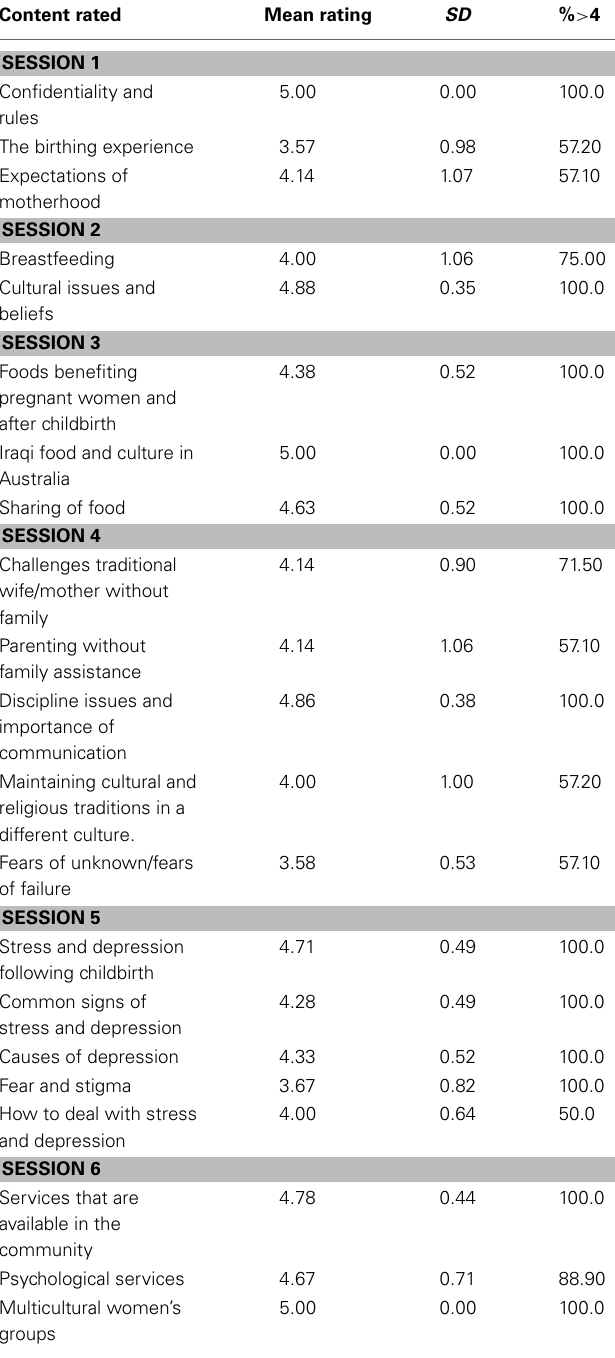
Table 4 | Mean participant ratings of the enjoyment of the individual Sessions (1, not at all enjoyable; 5, I enjoyed it very much), with the percentage of participants who gave ratings of 4 and